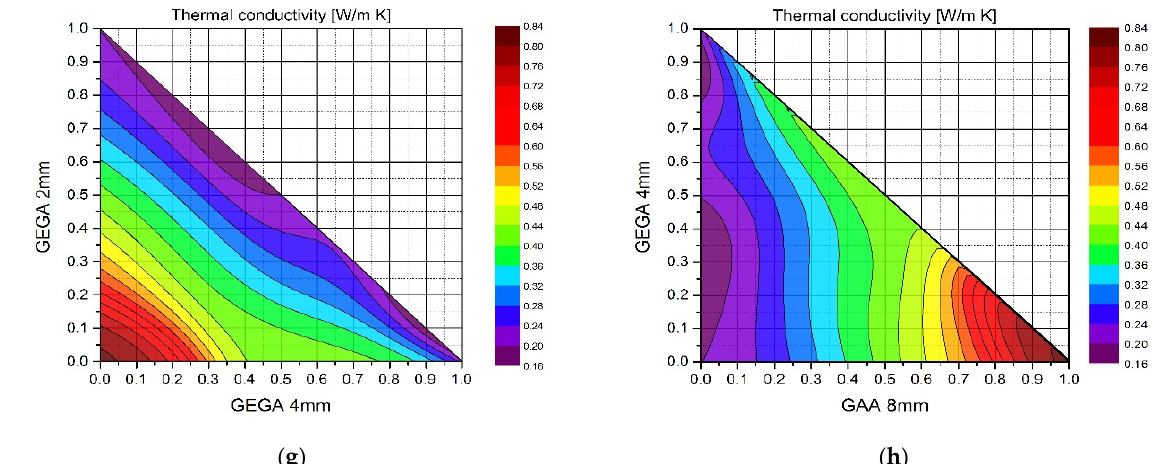
Figure 4. Graphical presentation of the results obtained by means of ANN method as a function of LWA share. Predicted results for: ( a , b ) density in (kg/m 3 ), ( c , d ) porosity in (%), ( e , f ) compressive strength in (MPa), ( g , h ) thermal conductivity in (W/m·K), respectively.